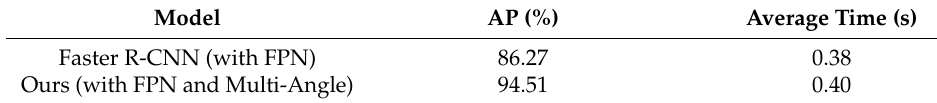
Table 7. Performance of models with different module on Dataset III.